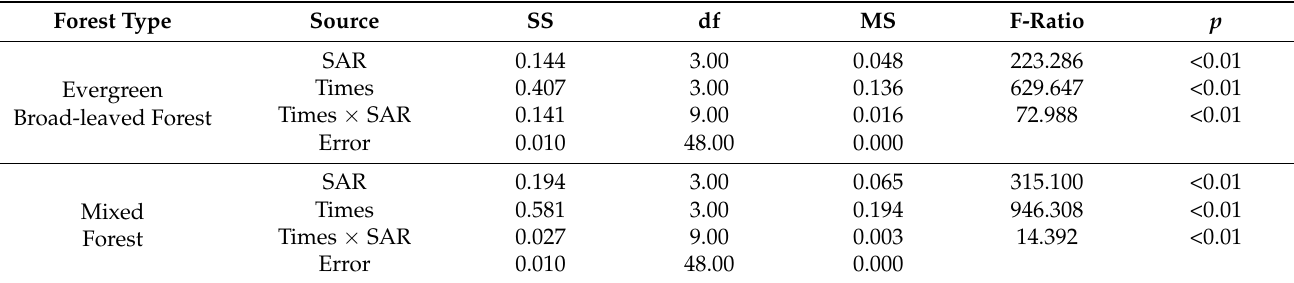
Table 7. ANOVA of soil urease activity.